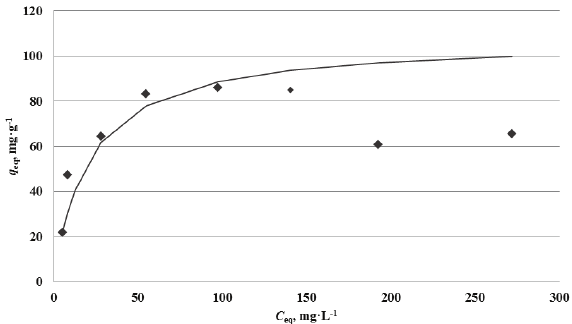
Figure 4: Langmuir isotherm for biosorption of Cr(III) ions by Figure 5. The changes in Cr(III) ions concentration in the solution during the biosorption Cladophora glomerata ( C 1.0 g·L -1 , pH 5). S process